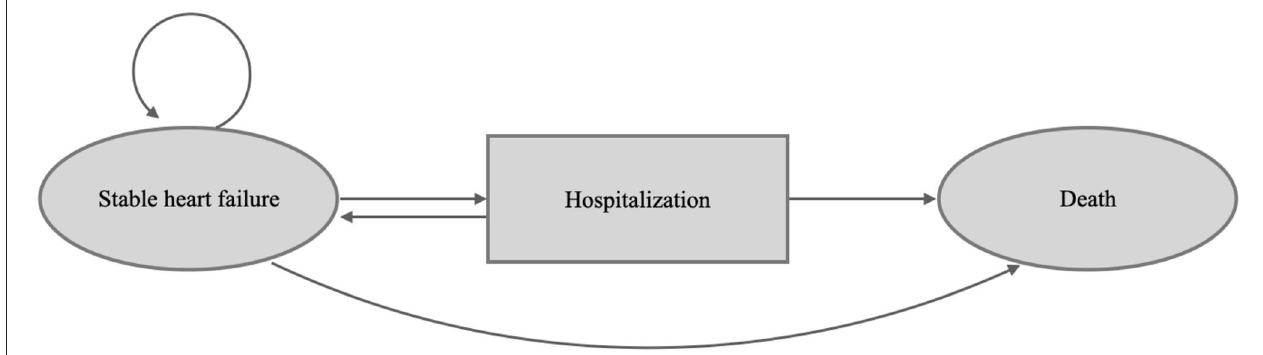
FIGURE 1 | Patients occupy health states, shown in the ovals. Patients transition from different health states represented as arrows based on transition